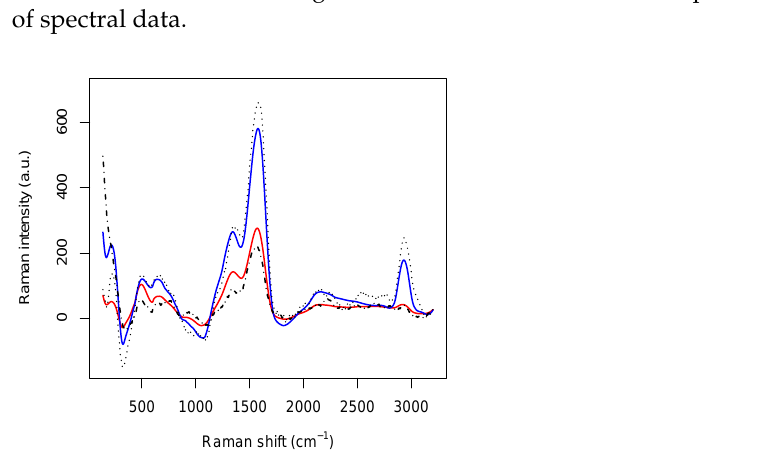
Figure 3. The red and the blue solid lines are, respectively, the average spectrum of the healthy and the tumoral data set. The point-dashed and the dashed lines report, respectively, one healthy and tumoral pre–processed spectrum. For the healthy spectrum, d t = 14.9 × 10 6 and d h = 4.7 × 10 6 . For the tumoral spectrum, d t = 2.8 × 10 6 and d h = 16.6 × 10 6